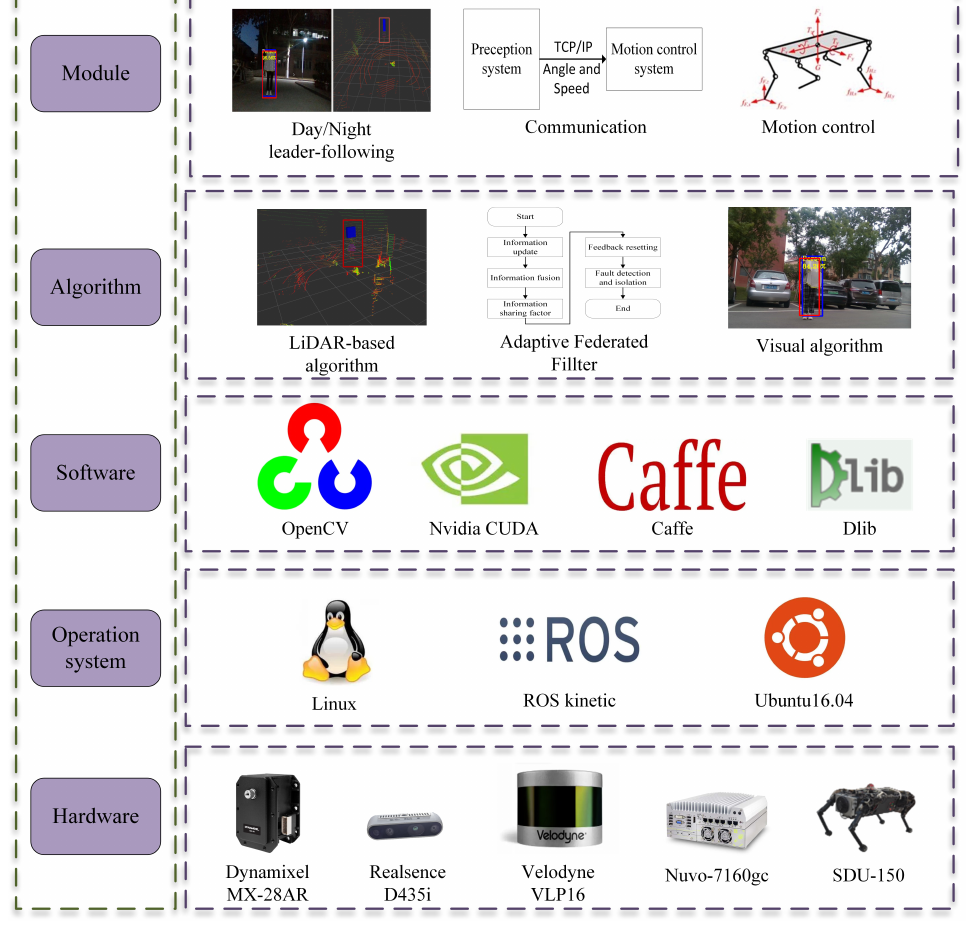
Figure 3. The day/night leader-following system, including application, algorithm, software, operat- ing system, and